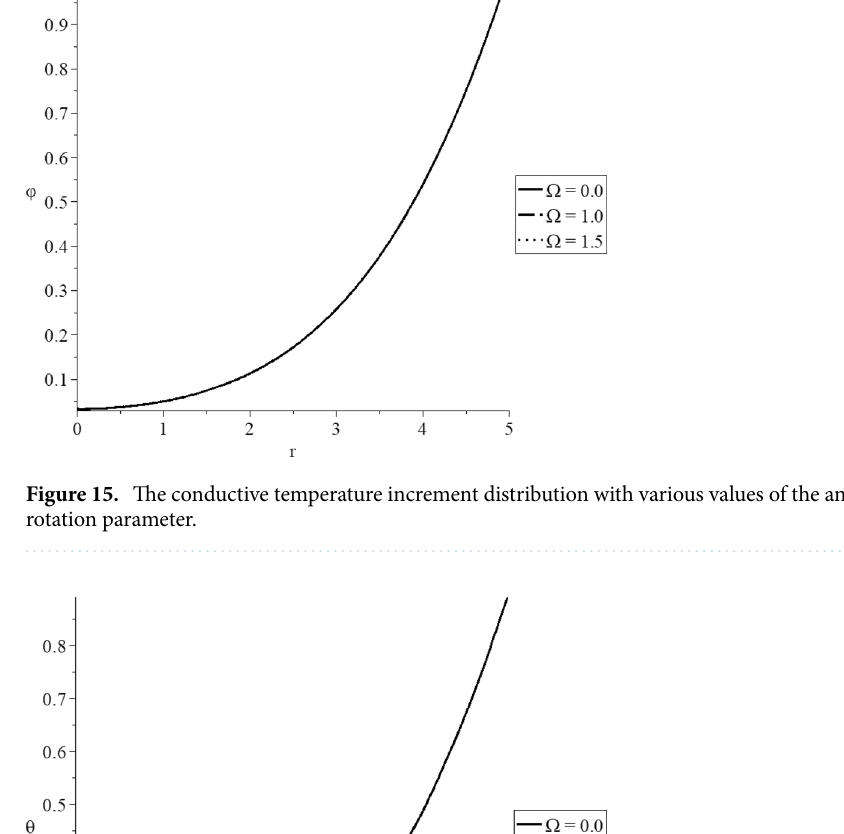
Figure 19 represents that the angular velocity parameter has significant effects on the average stress distri- butions. The absolute value of the average stress increases when the value of the angular velocity parameter increases.